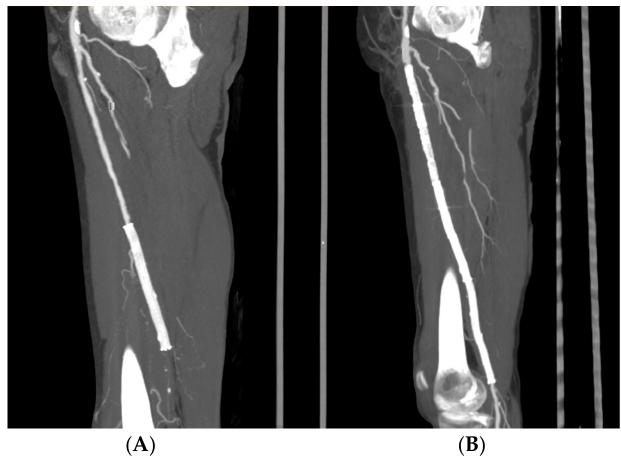
Figure 2. Preoperative CT MPR showing multilevel peripheral arterial disease compared to a common superficial artery, an in stent occlusion, and a distal superficial femoral artery occlusion ( A ). Postoperative CT MPR showing the outcome after common femoral artery patch angioplasty, stent recanalization, and superficial femoral artery stenting ( B